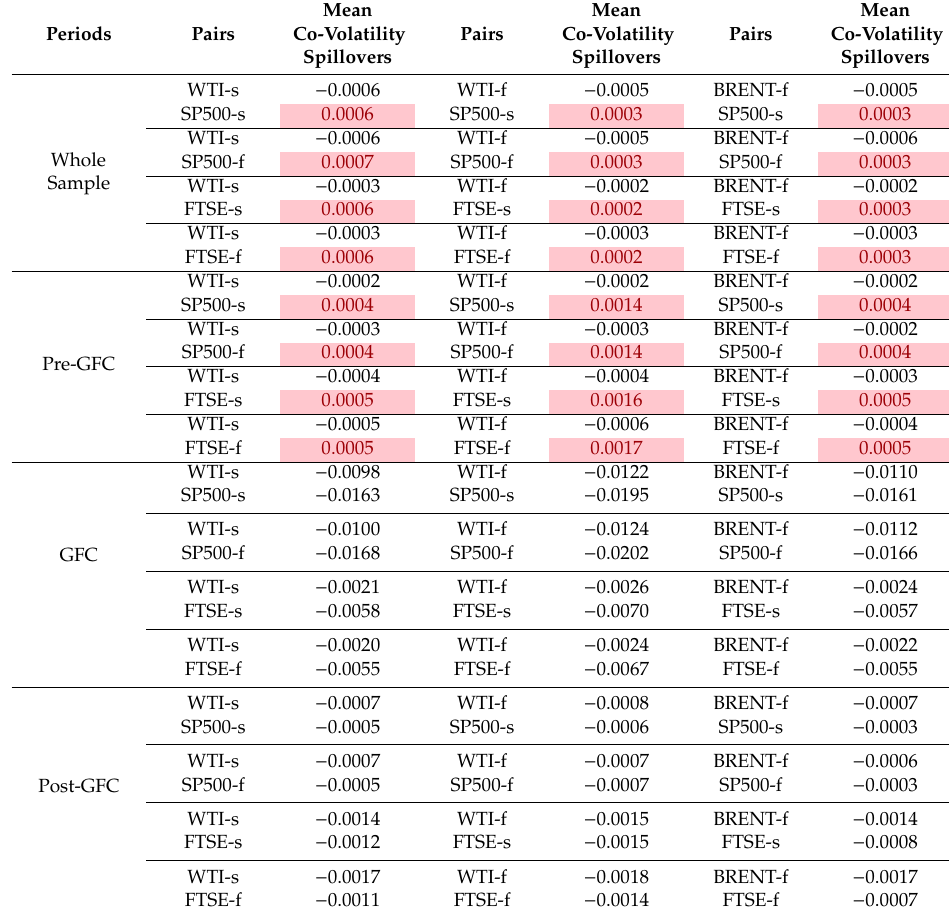
Table 10. Mean co-volatility spillovers for the UK and the USA spot and futures markets, four periods (7 ×